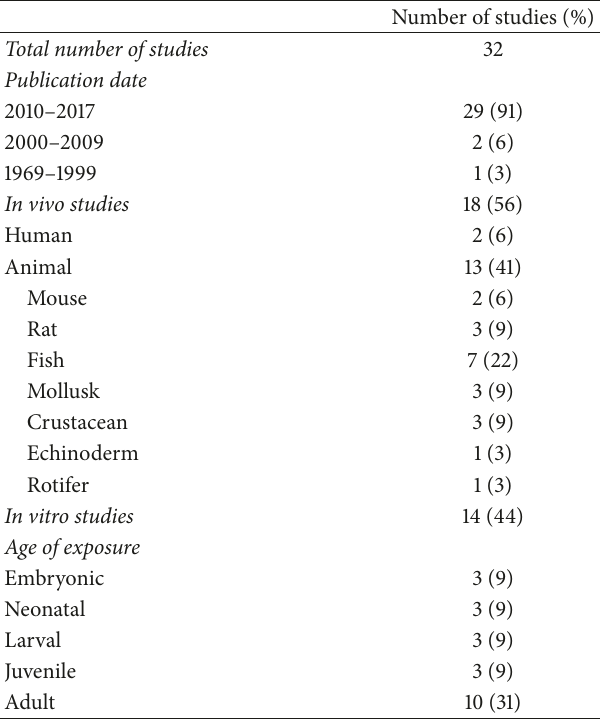
Table 1: Summary of the studies evaluating the endocrine, repro- ductive, and developmental effects of